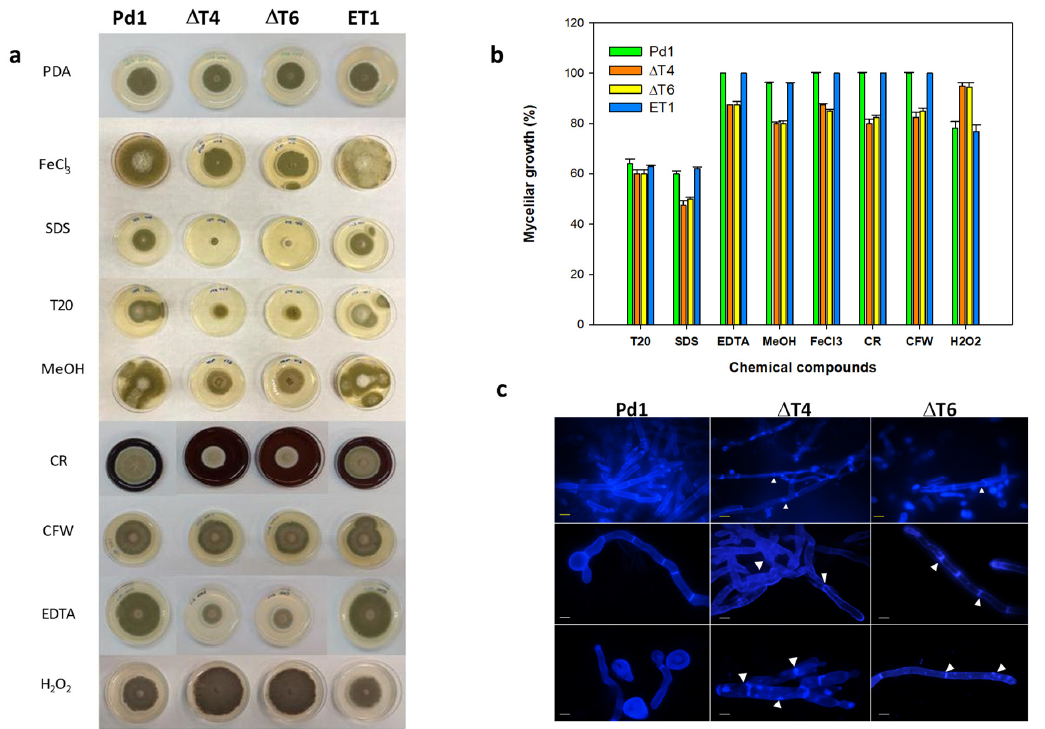
Figure 5. ( a ) Fungal growth of Pd1, ET1, and Δ PdMut3 mutant ( Δ T4, Δ T6) on PDA amended with different chemical compounds during 5 days: FeCl 3 , SDS, Tween 20 (T20), methanol (MeOH), Congo red (CR), calcofluor white (CFW), EDTA, and H 2 O 2 . ( b ) Percentage of growth reduction of Δ PdMut3 in relation to that grown on PDA amended with different concentrations of chemical compounds after 7 days. ( c ) The effects on the cell wall of spores and mycelia of P. digitatum strains observed under a fluorescence microscope after staining with calcofluor white (CFW). White arrows point out strangulation in the hyphae and variation in the septum. Yellow bars correspond to 20 µm and white bars to 40 µm.